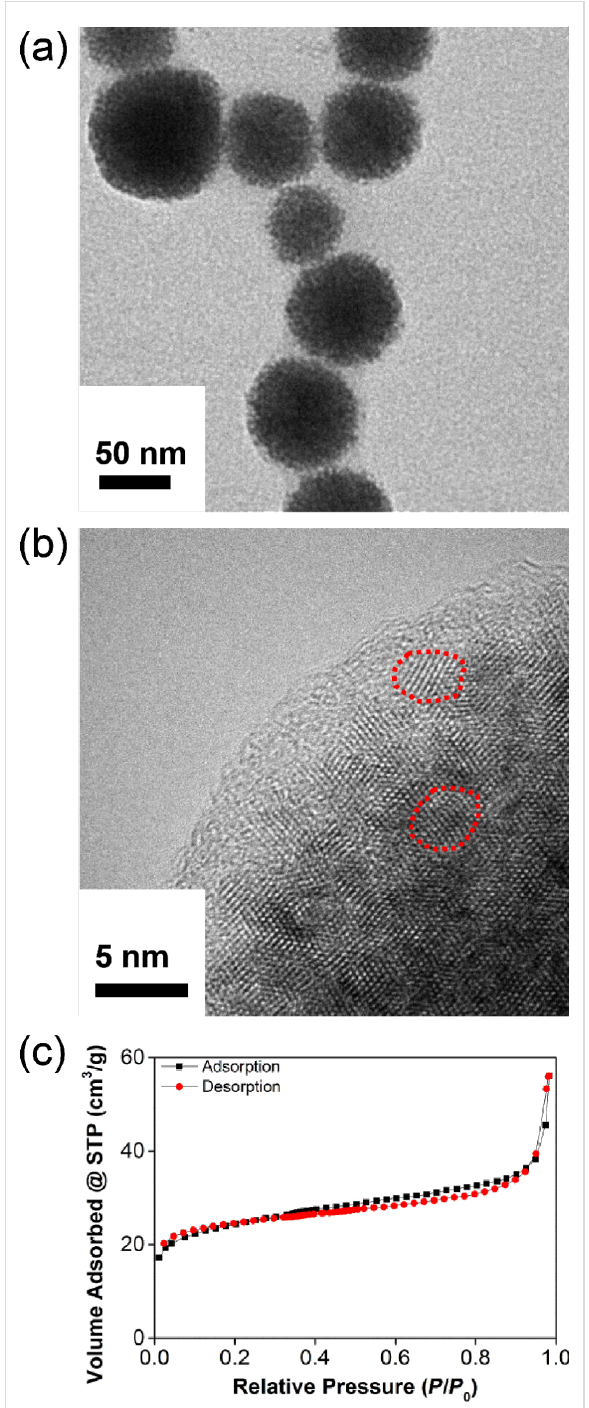
Figure 3: (a) TEM and (b) HRTEM images of the mesoporous cerium oxide nanospheres. (c) Nitrogen adsorption–desorption isotherm of the mesoporous cerium oxide nanospheres.